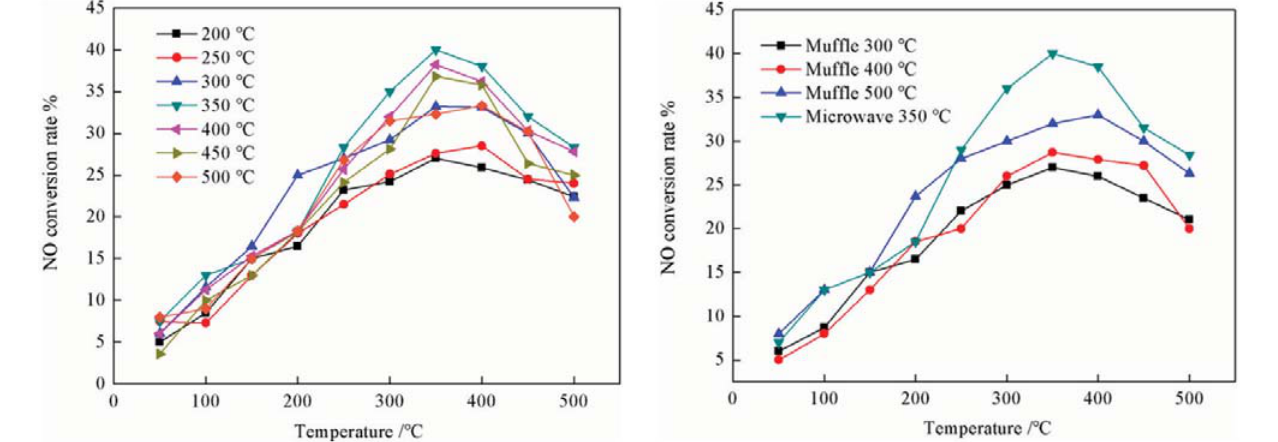
Figure 5: Comparison the denitrification rate for different microwave roasting temperatures.